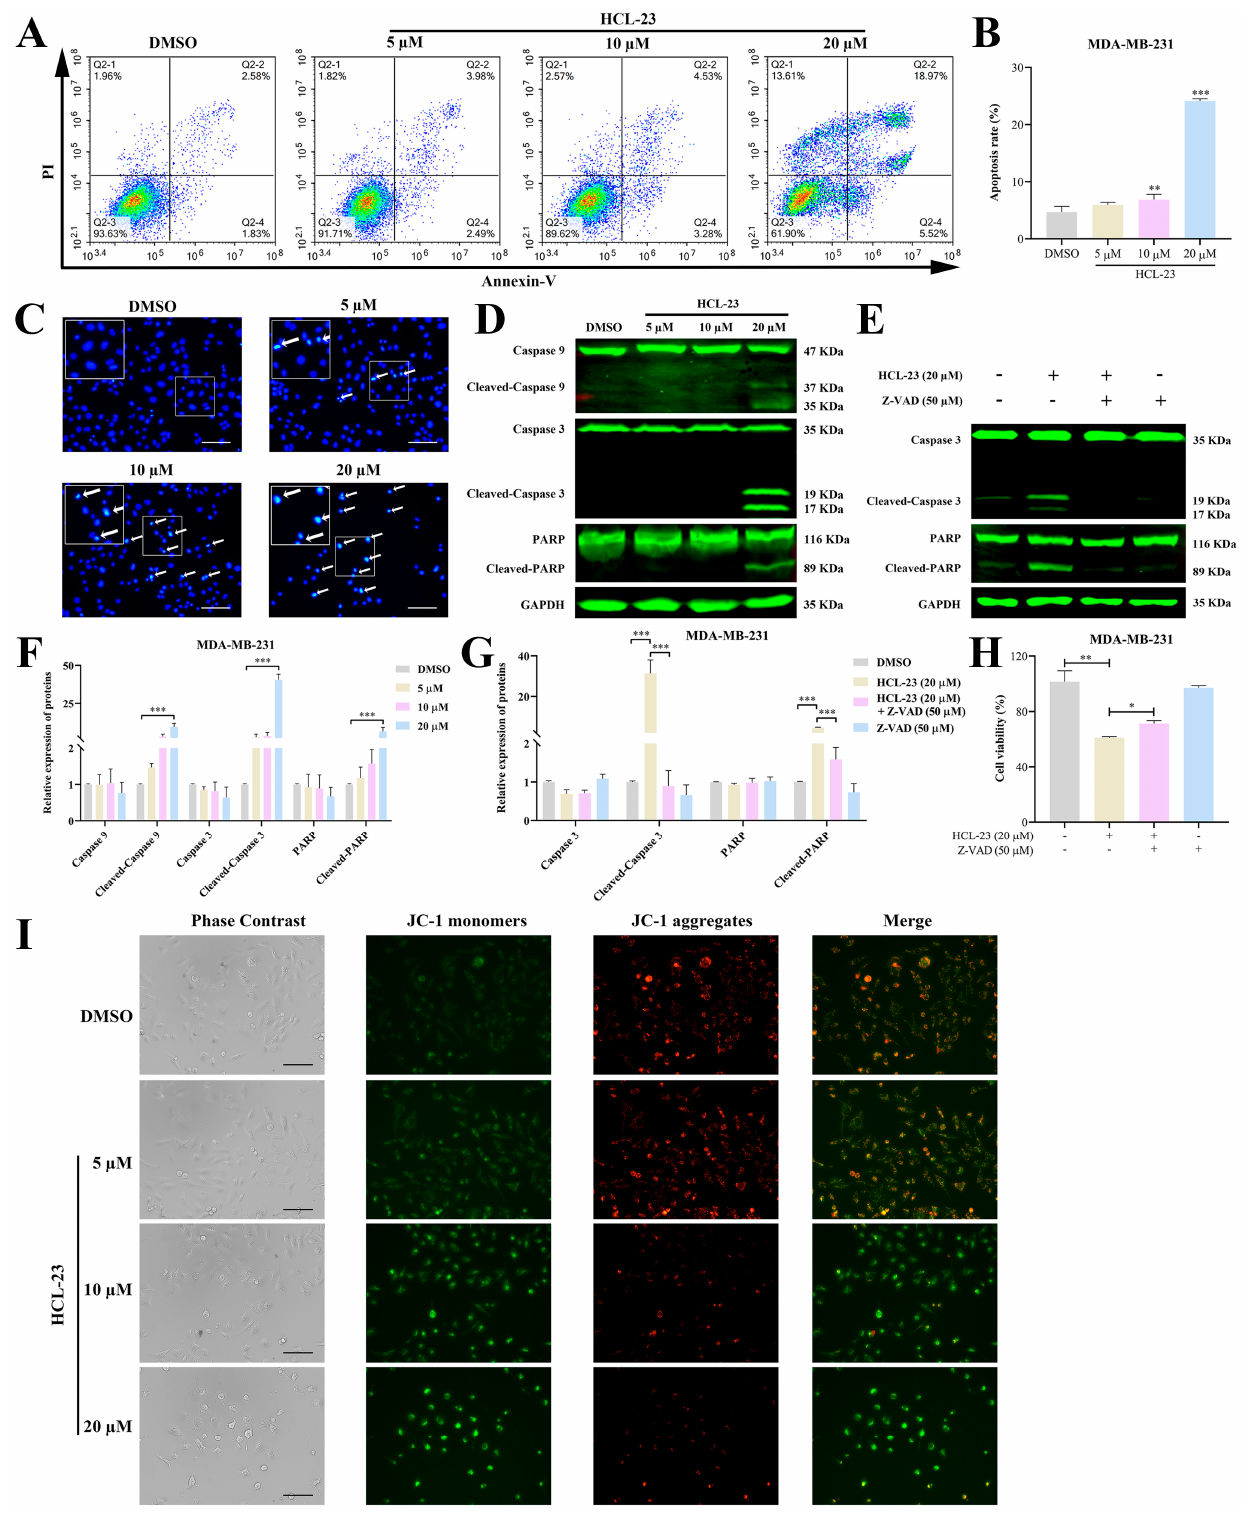
Figure 5. HCL-23 induces apoptosis in MDA-MB-231 cells. ( A ) Annexin V-FITC/PI double staining was used to assess the apoptosis of MDA-MB-231 cells induced by HCL-23 (5, 10, and 20 µ M) for 24